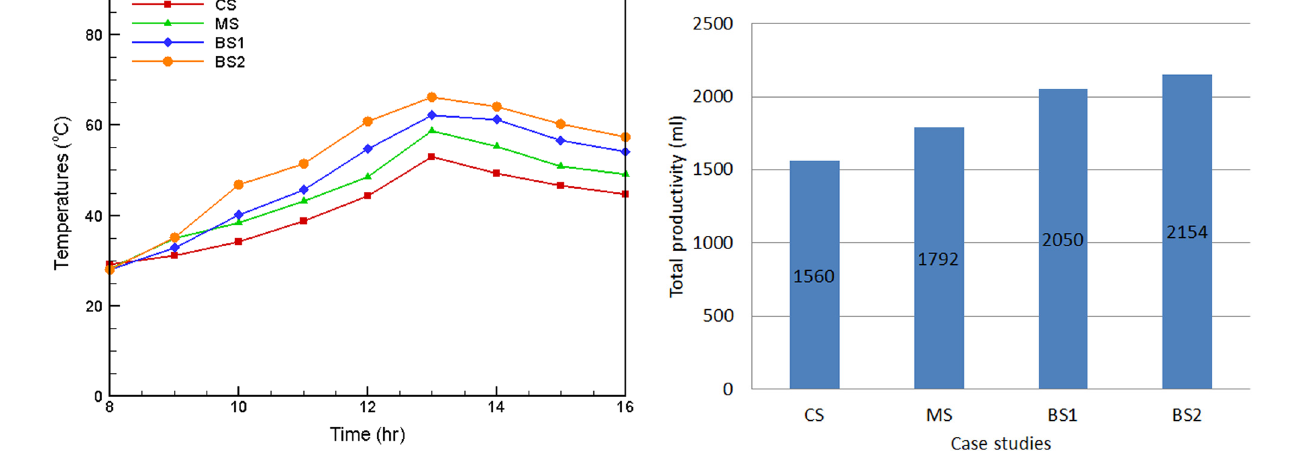
Figure 13: The total productivity of fresh water.